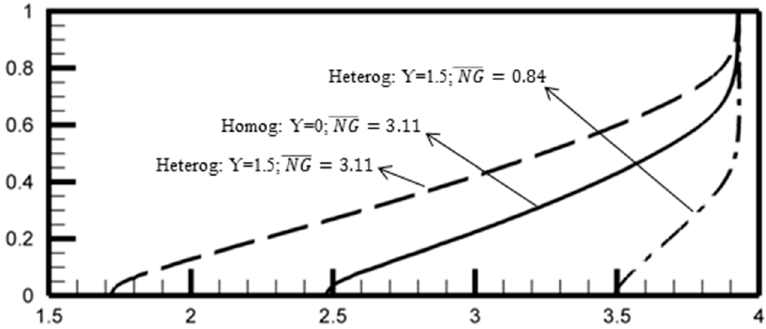
Figure 10. Effect of the heterogeneity for a varying large-scale gravity number. The 50% isochlor in the case of the homogenous aquifer with NG = 3.11 (solid line), heterogeneous aquifer with NG = 3.11 (dashed line) and heterogeneous aquifer with NG = 0.84 (dash-dotted line). Heterogeneous cases are obtained with Υ = 1 5 .